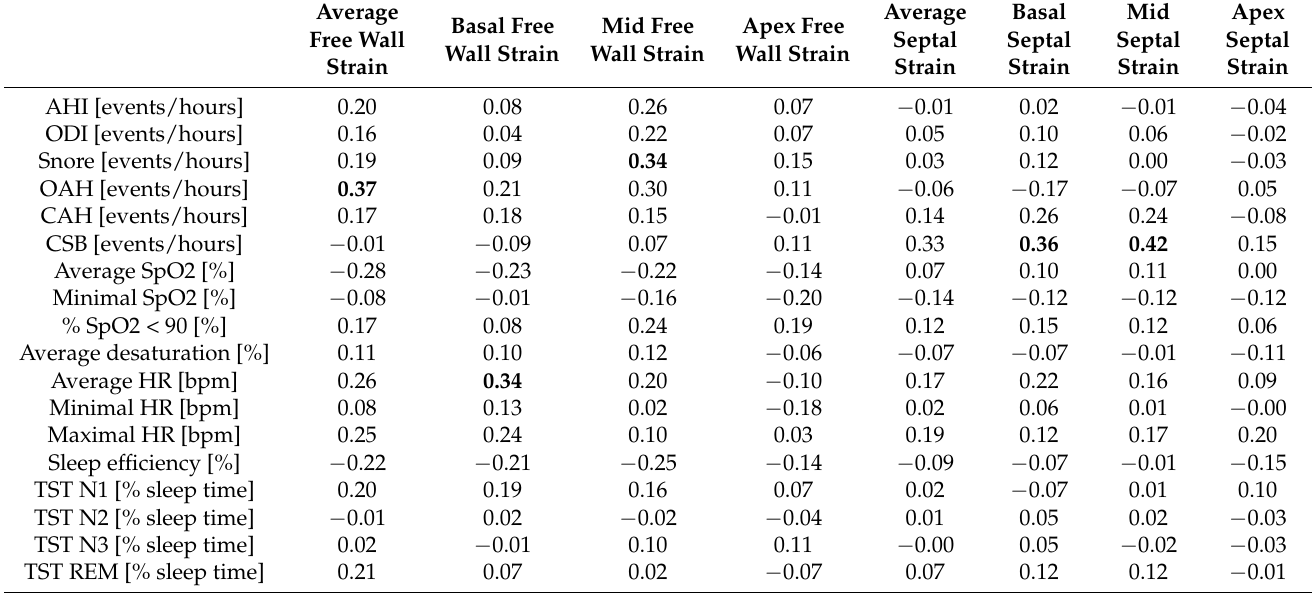
Table 6. Correlations between polysomnography parameters and right ventricular strain parameters in whole study group (the statistically significant correlation coefficients were